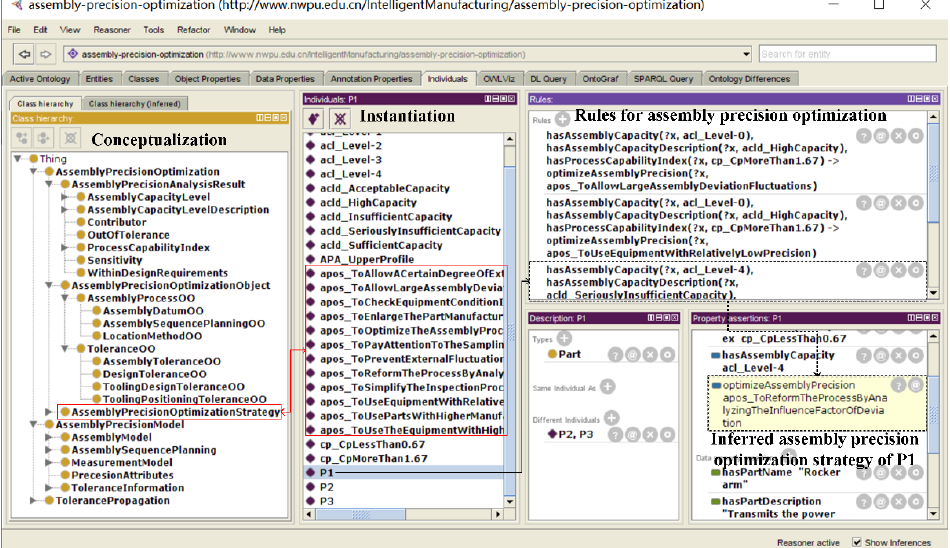
Figure 9. Instantiation of the pushed assembly precision optimization strategy.